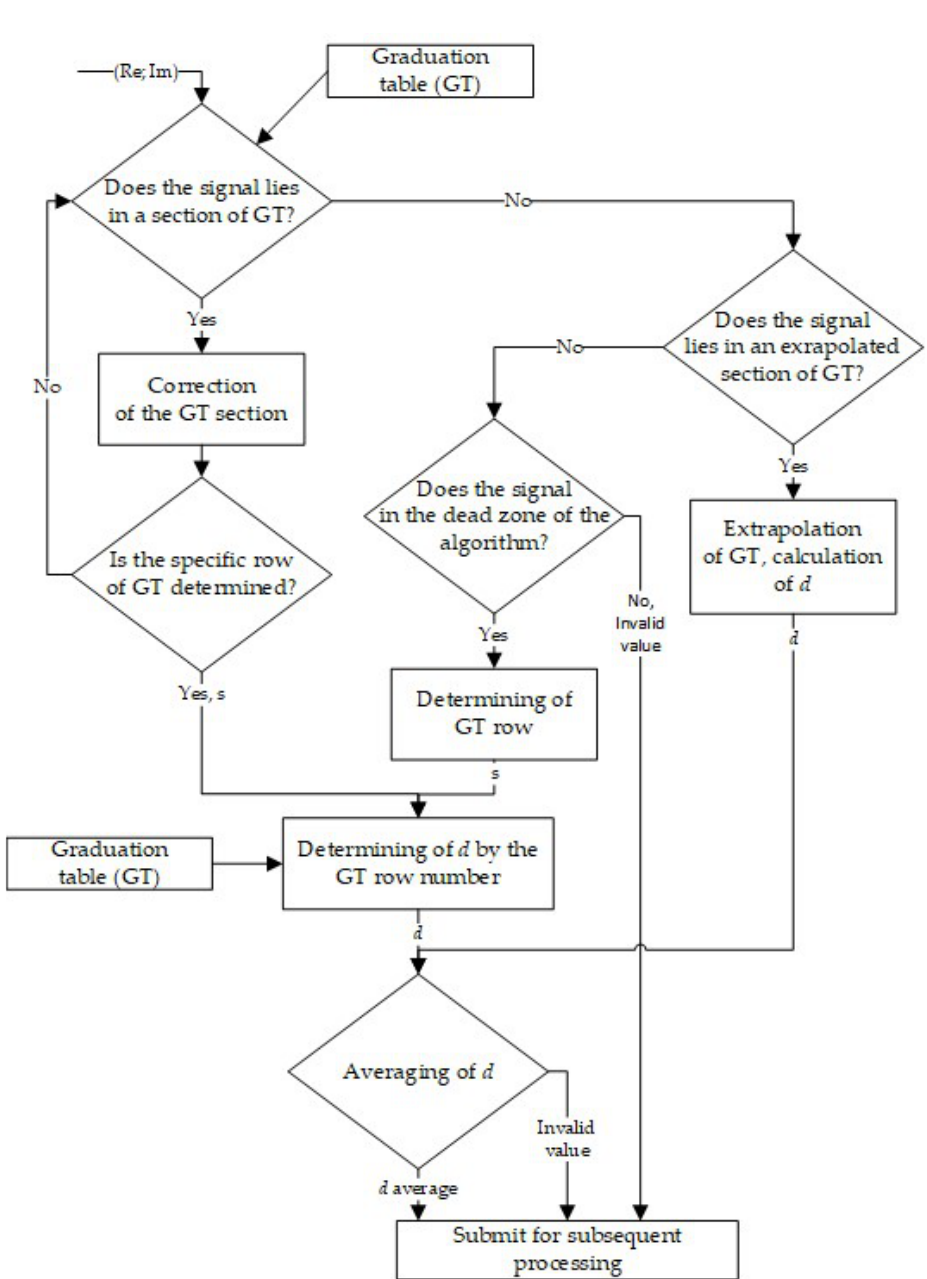
Figure 8. Two-dimensional algorithm of the calculation σ and d . The lines of the graduation characteristic obtained on different reference base metals are presented as lines d ( σ ). These lines converge fanwise at a single point—an air point with coordinates (Re Air ; Im Air ). For clarity, the points with the same d value on different lines of the graduation characteristic are connected by lines which are denoted as σ ( d